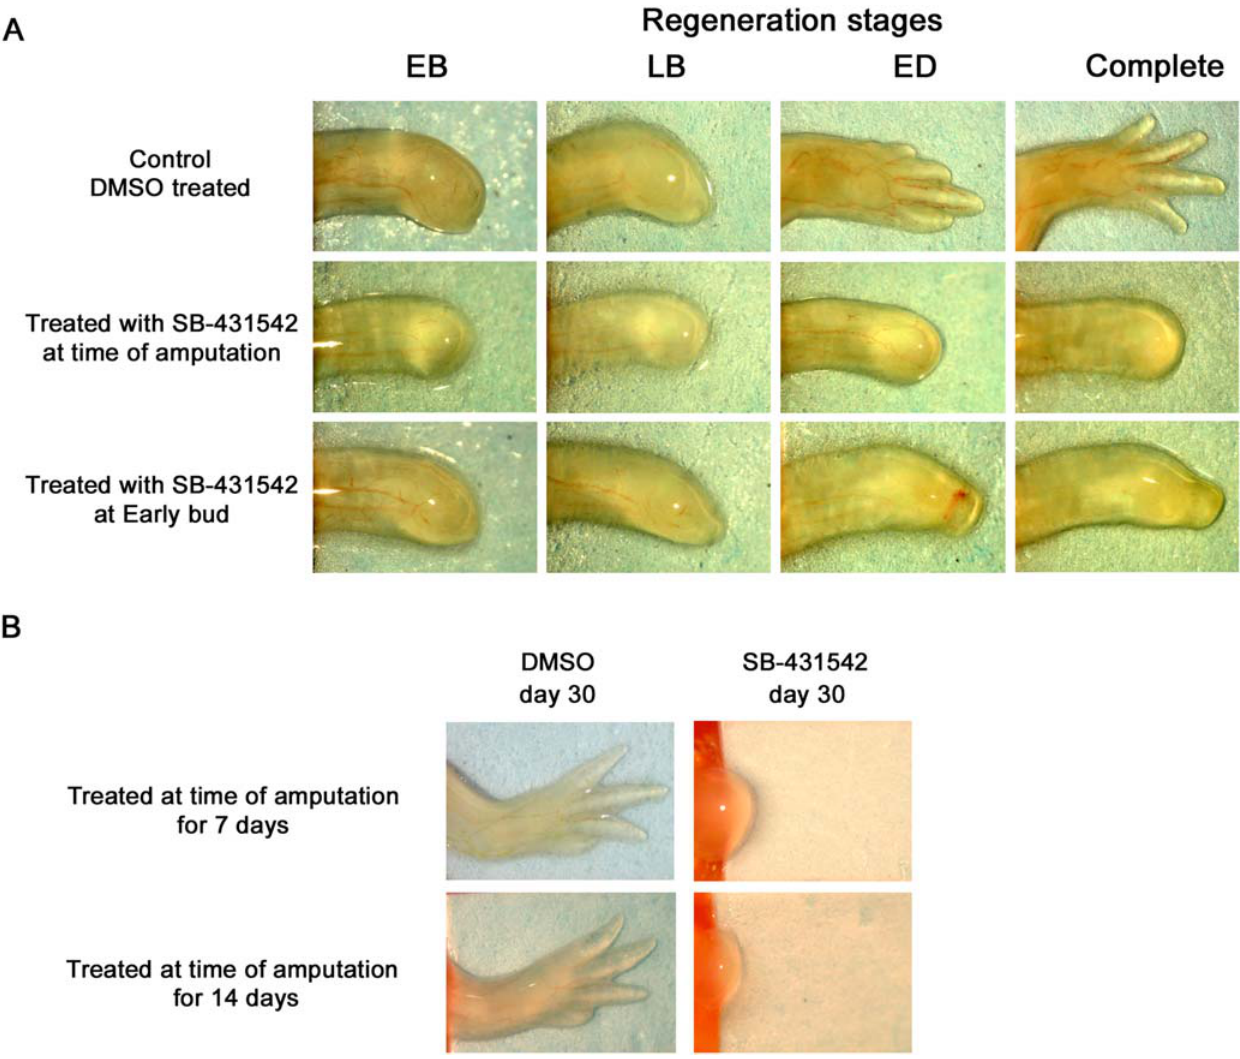
Figure 4. Inhibition of limb regeneration by SB-431542. A) Morphology of axolotl regenerating forelimbs treated with SB-431542. Top row: morphology of a regenerating control limb treated with DMSO. All limbs were distally amputated on the same day. Limbs were photographed when control limbs reached each of the stages indicated on top: early bud (EB), late bud (LB), early differentiation (ED). Complete: regeneration of control limb ended after 30 days. Middle row: morphology of an axolotl limb treated with 25 m M SB-431542 from the time of amputation until the control had regenerated (30 days). Complete inhibition of regeneration and absence of blastema formation were observed in these limbs. Bottom row: morphology of an axolotl limb treated with 25 m M SB-431542 from early bud stage until the control had regenerated. Growth of the blastema was observed in these limbs until it resembled a late bud blastema. B) Inhibition of regeneration with SB-431542 cannot be rescued after 7 or 14 days of treatment. In this panel, limbs were treated with DMSO or SB-431542 from the moment of amputation for the first 7 or 14 days only. Results show that limbs treated with SB-431542 for the first 7 or 14 days after amputation do not regenerate even if treatment was stopped. Control limbs treated for 7 and 14 days with DMSO regenerated